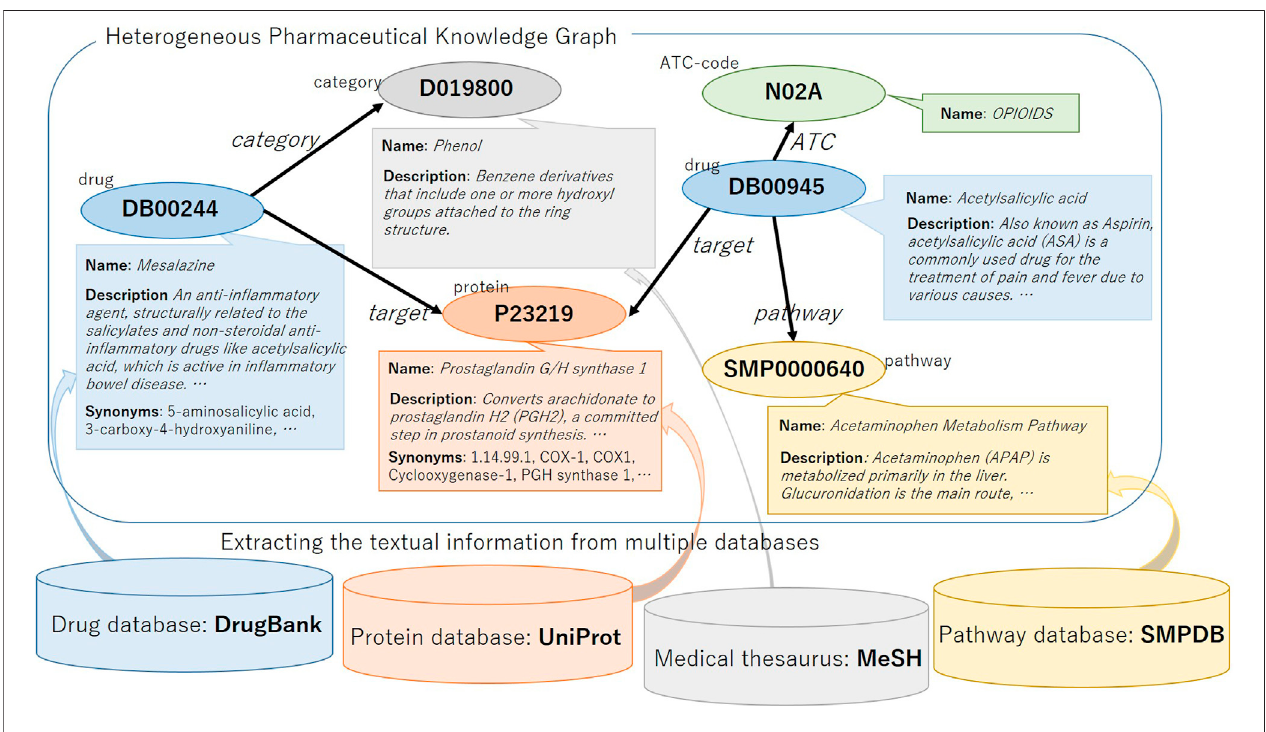
FIGURE 1 | Illustration of the heterogeneous pharmaceutical knowledge